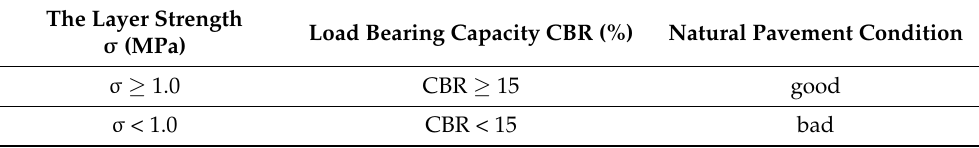
Table 2. Assessment criteria of the load bearing capacity for the natural AFE to a depth of 0.15 m (layer 1).